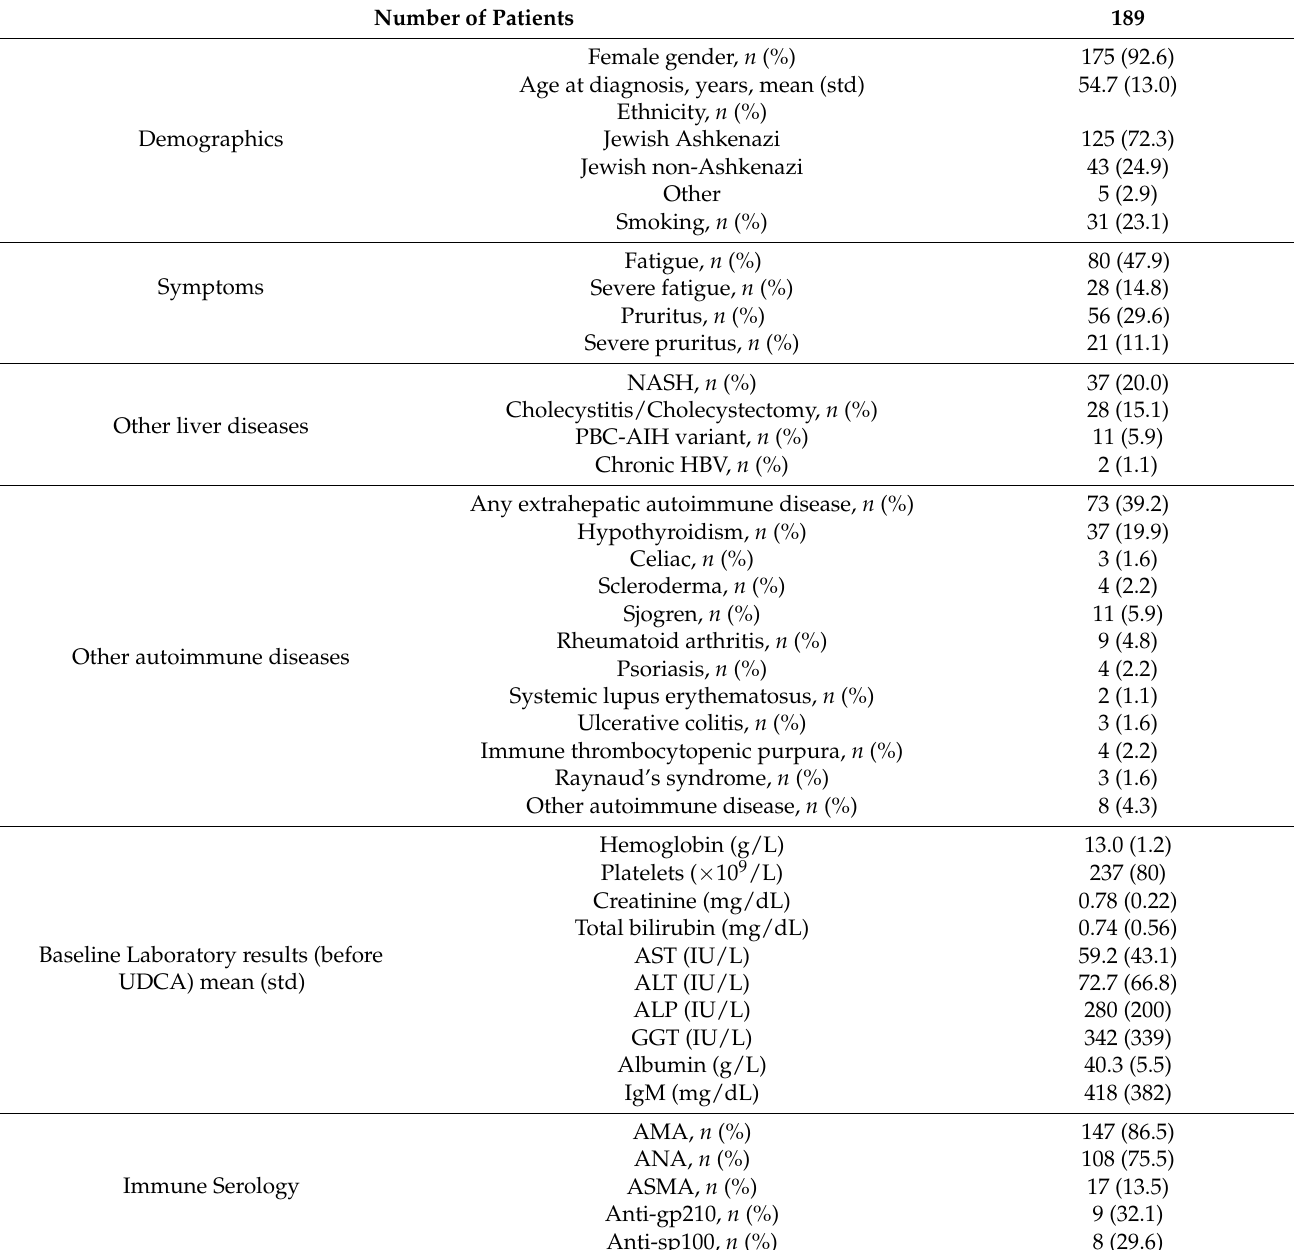
Table 1. Patients, disease characteristics, laboratory values, treatment patterns and clinical